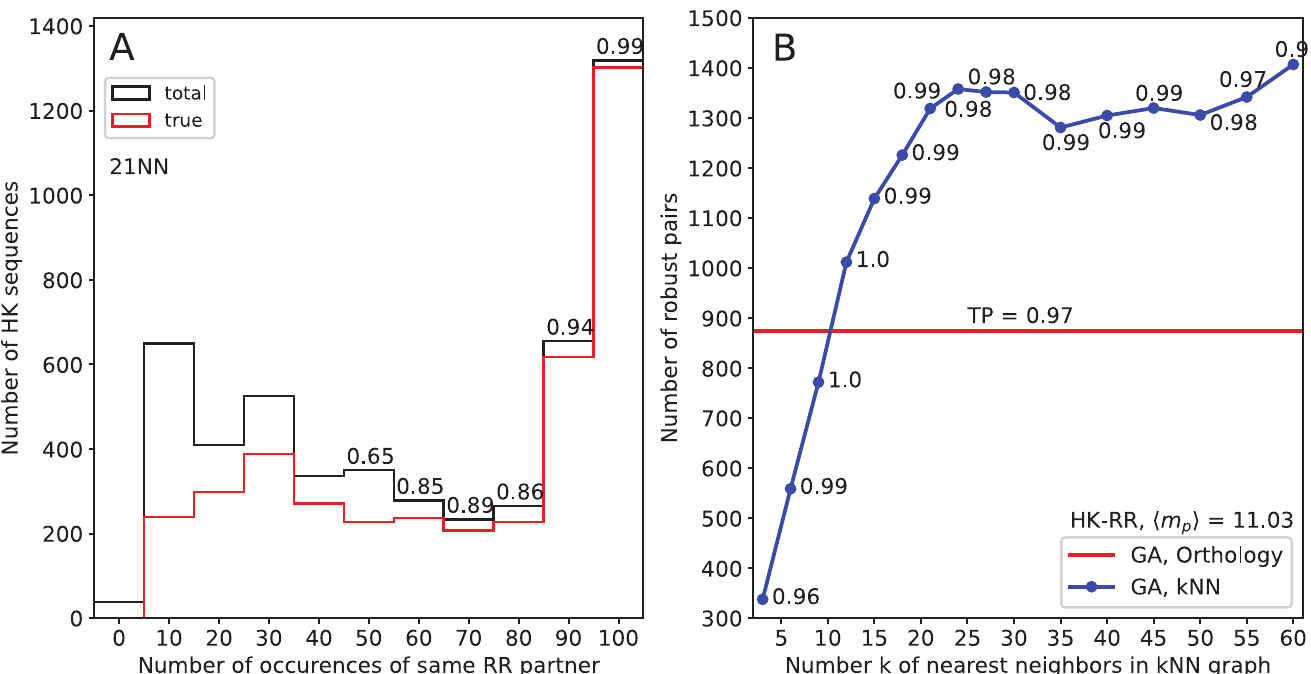
Fig 3. Robustness of GA. (A) Robustness histograms for the 21-NN graph. We perform 100 GA runs and count how many times a HK is paired to the same RR. The horizontal axis gives the number of times a given pair appears, and the vertical axis is the number of pairs appearing that many times across replicates. Black bars are the total number of pairs, and red bars are the number of TPs. The TP ratios are indicated on top of the bars. (B) Number of robust pairs (occurring in all 100 GA runs) obtained by GA for each similarity network. The fraction of correctly matched pairs in this robust subset is indicated in each case.